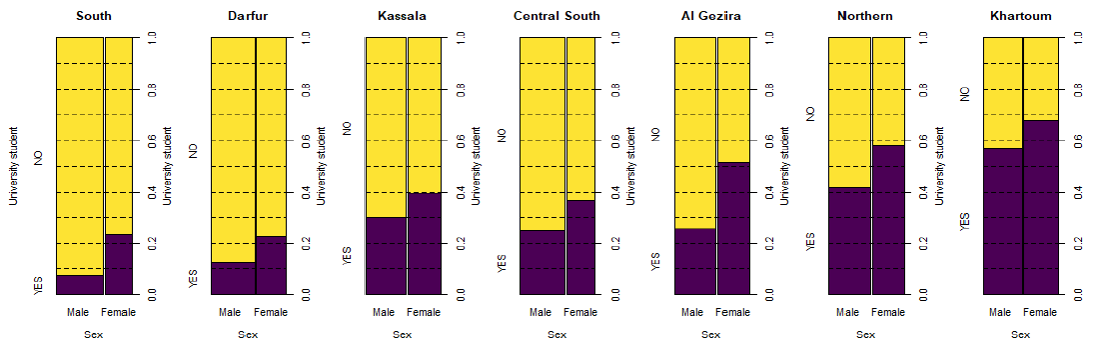
Figure 3. University attendance rates for rural and urban 19–21-year-olds, by region.